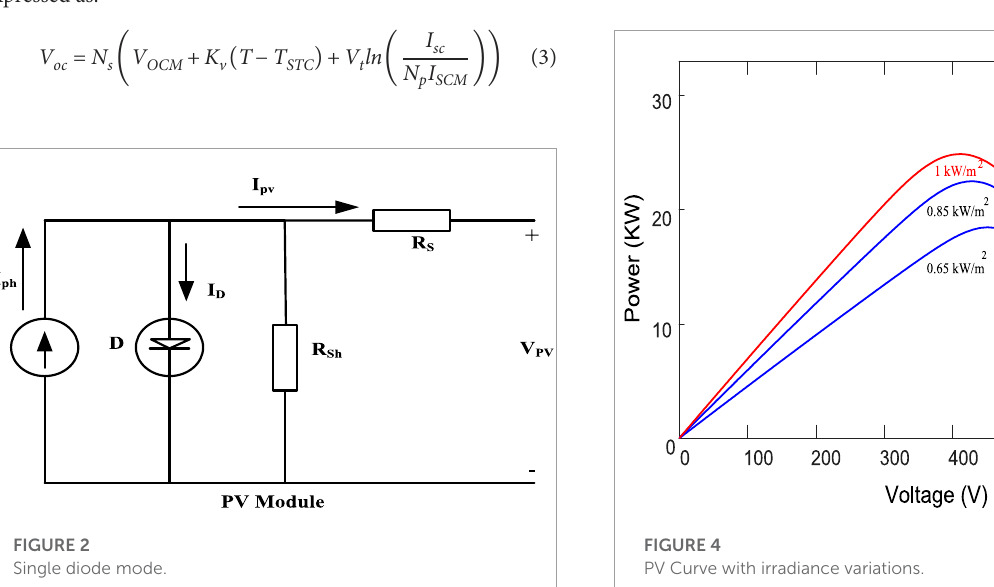
FIGURE 2 Single diode mode.